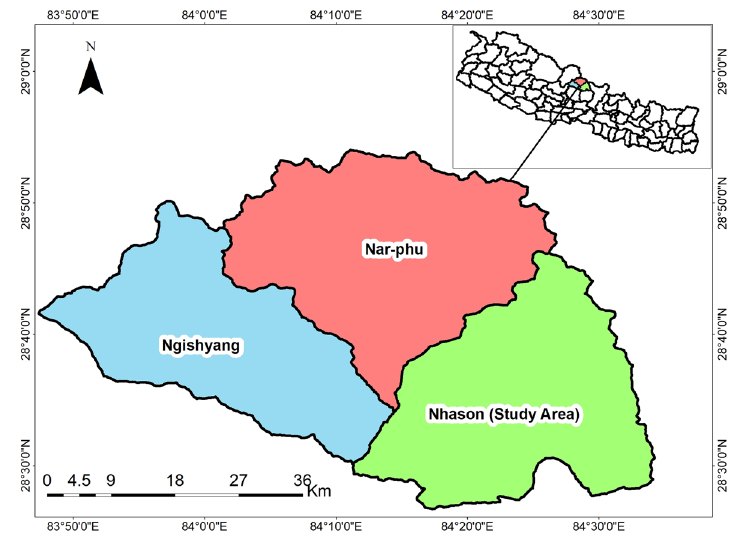
Fig. 1 Map of the Study